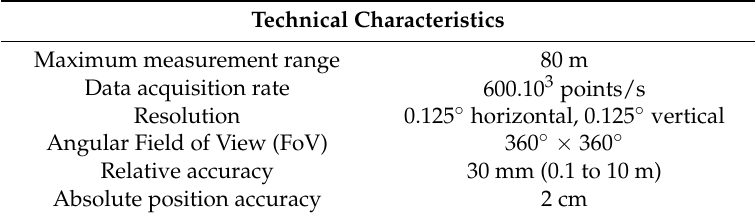
Table 1. Technical characteristics of the Viametris IMS3D laser scanning device according to the manufacturer’s datasheet.